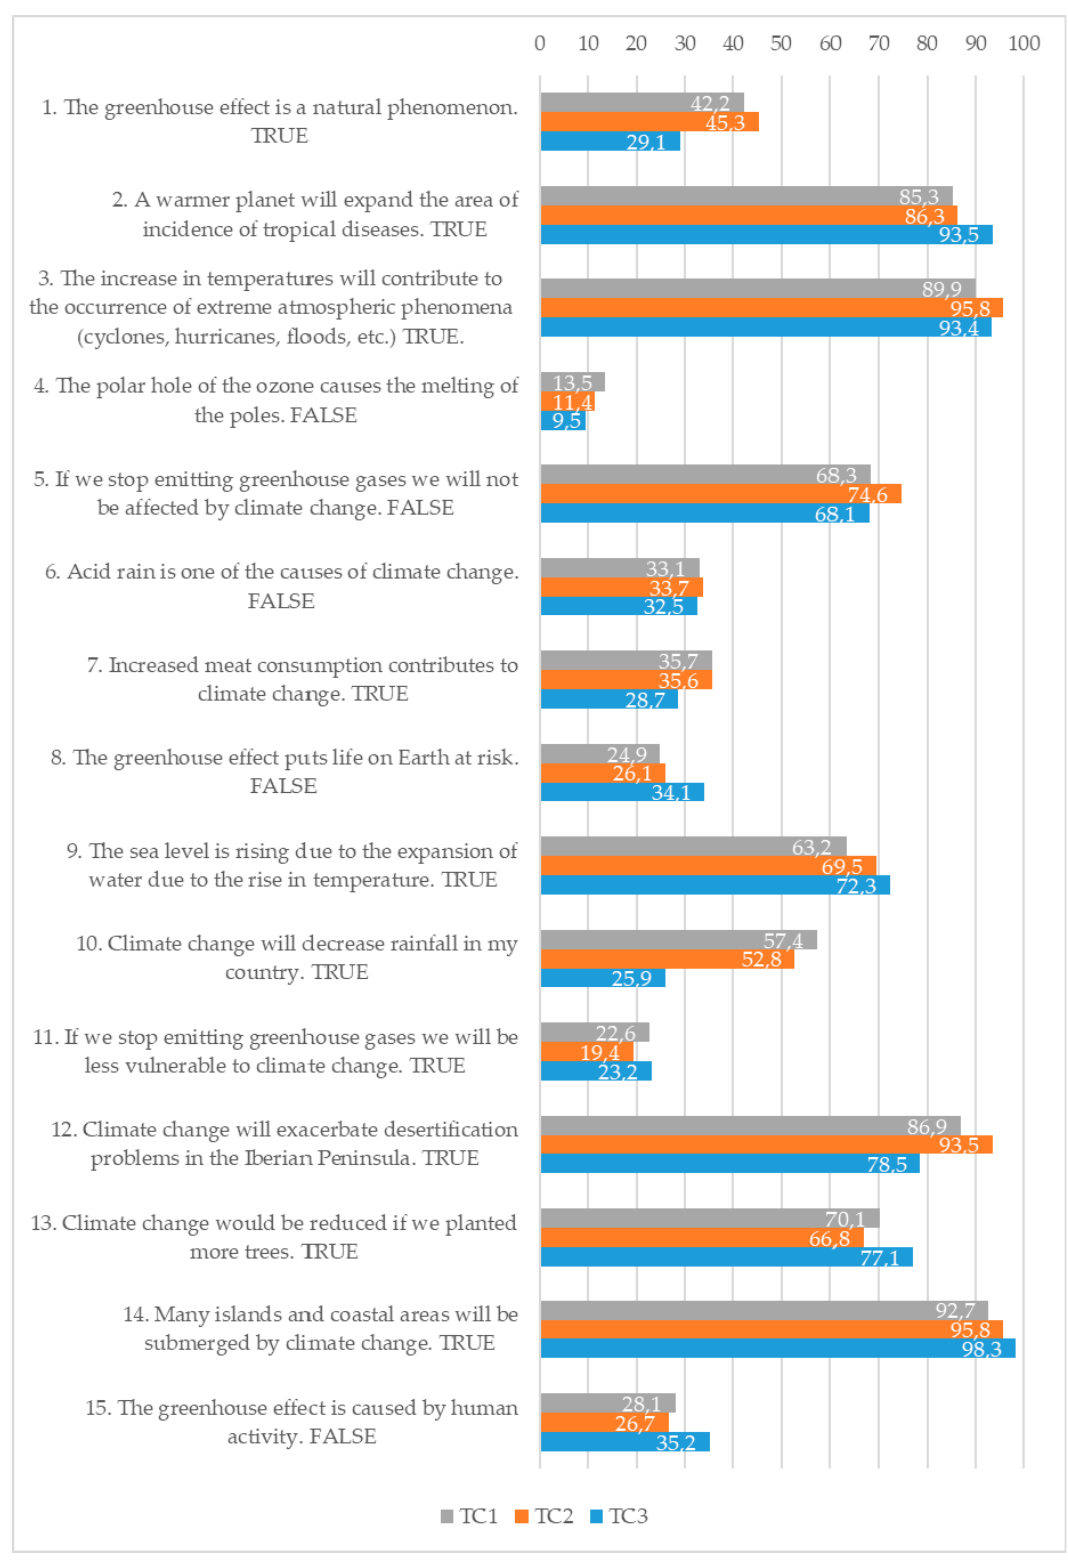
Figure 7. Conceptual questions about CC.